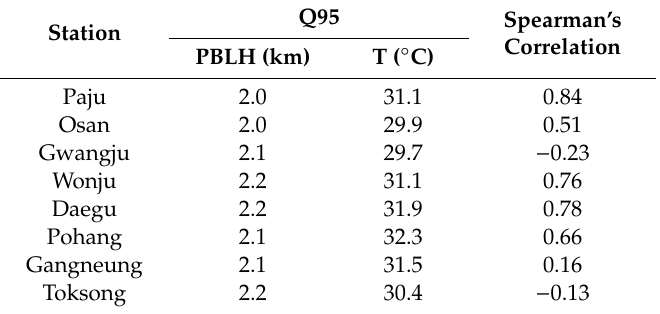
Table 5. Q95 and Spearman correlations of PBLH and T.